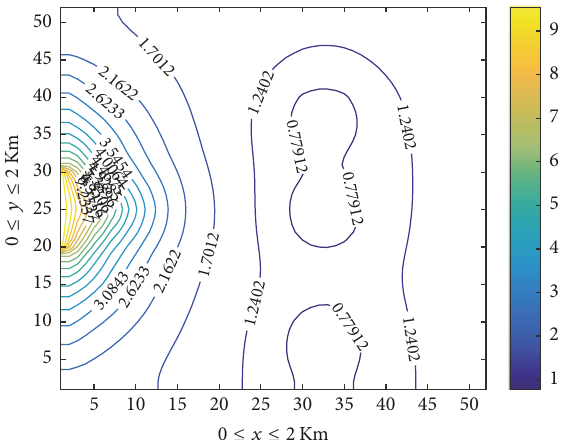
Figure 17: The overall approximated pollutant concentrations when the eastern exit gate is opened on the period